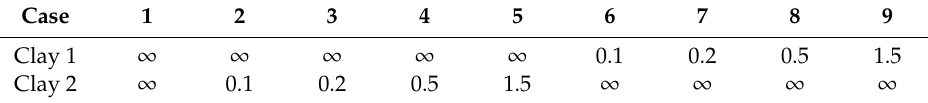
Table 7. Di ff erent cases for the study of the e ff ects of the smoothness parameter ν . Table 7. Different cases for the study of the effects of the smoothness parameter ν .